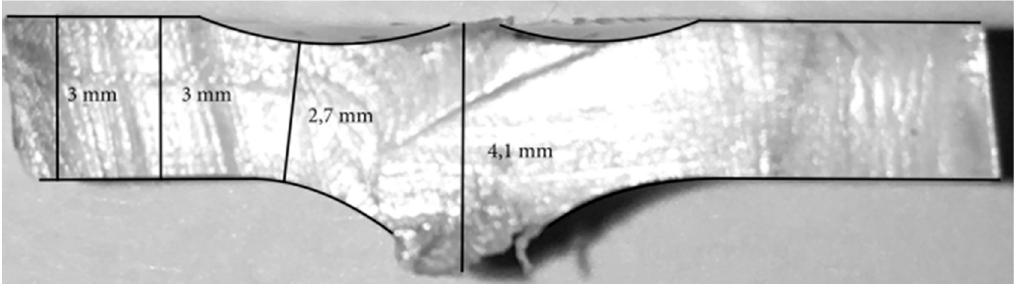
Figure 10. Enlarged photograph of a specimen sectioned at the puncture location. Thickness profile after the first shot.